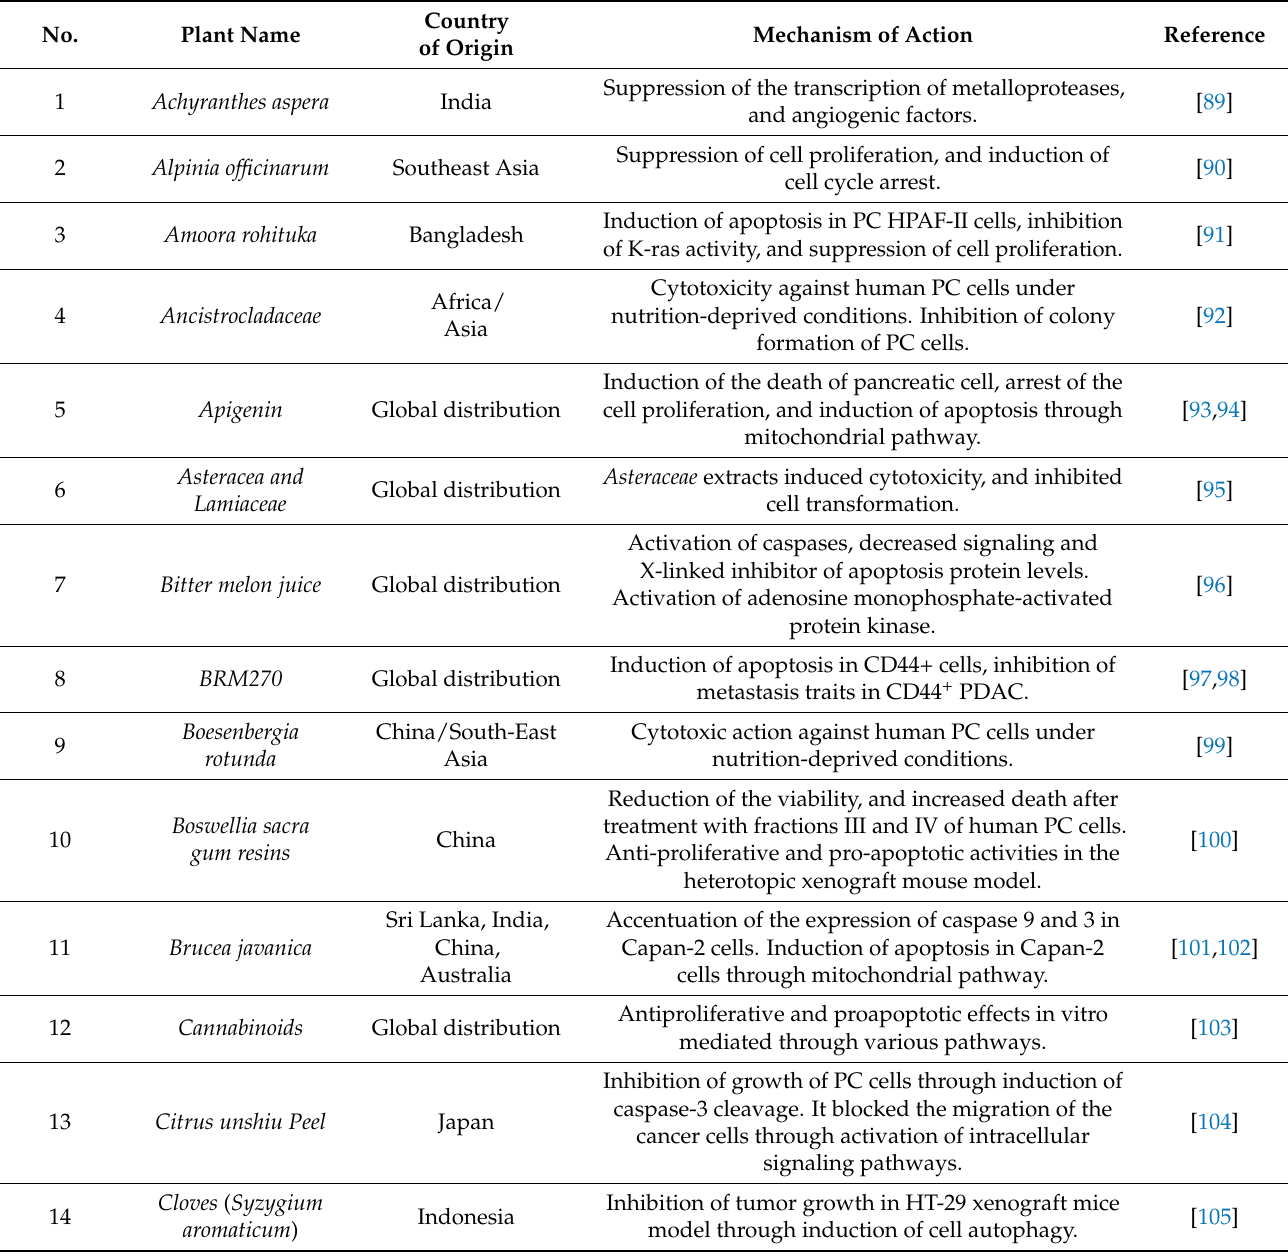
Table 2. Names, country of origin, and mechanisms of anticancer effects of plant extracts investigated against pancreatic cancer cell